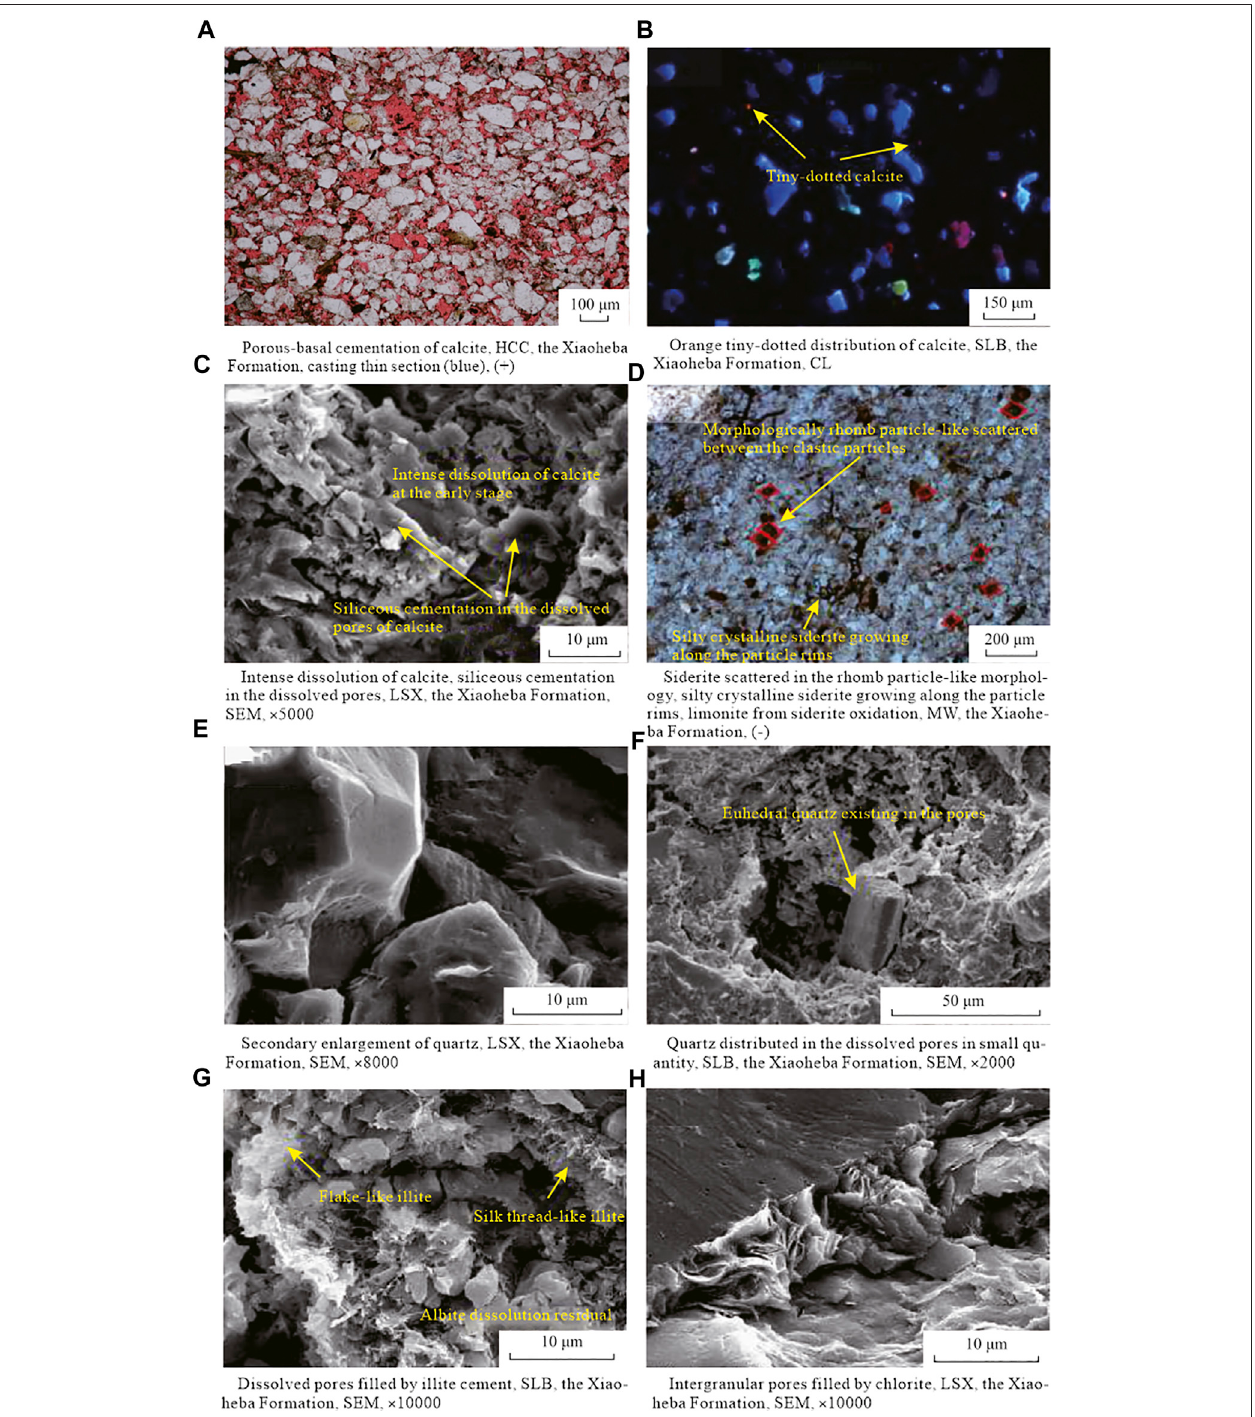
FIGURE 8 | Types and features of carbonate cementation of the Xiaoheba Formation reservoirs in Southeast Sichuan, (A) Porous-basal cementation of calcite, HCC, the Xiaoheba Formation, casting thin section (blue), (+); (B) Orange tiny-dotted distribution of calcite, SLB, the Xiaoheba Formation, CL; (C) Intense dissolution of calcite, siliceous cementation in the dissolved pores, LSX, the Xiaoheba Formation, SEM, ×5000; (D) Siderite scattered in the rhomb particle-like morphology, silty crystallinesideritegrowingalongtheparticlerims,limonitefromsideriteoxidation,MW,theXiaohebaFormation,( − ); (E) Secondaryenlargementofquartz,LSX,the Xiaoheba Formation, SEM, ×8000; (F) Quartz distributed in the dissolved pores in small quantity, SLB, the Xiaoheba Formation, SEM, ×2000; (G) Dissolved pores fi lled by illite cement, SLB, the Xiaoheba Formation, SEM, ×10000; (H) Intergranular pores fi lled by chlorite, LSX, the Xiaoheba Formation, SEM, ×10000.